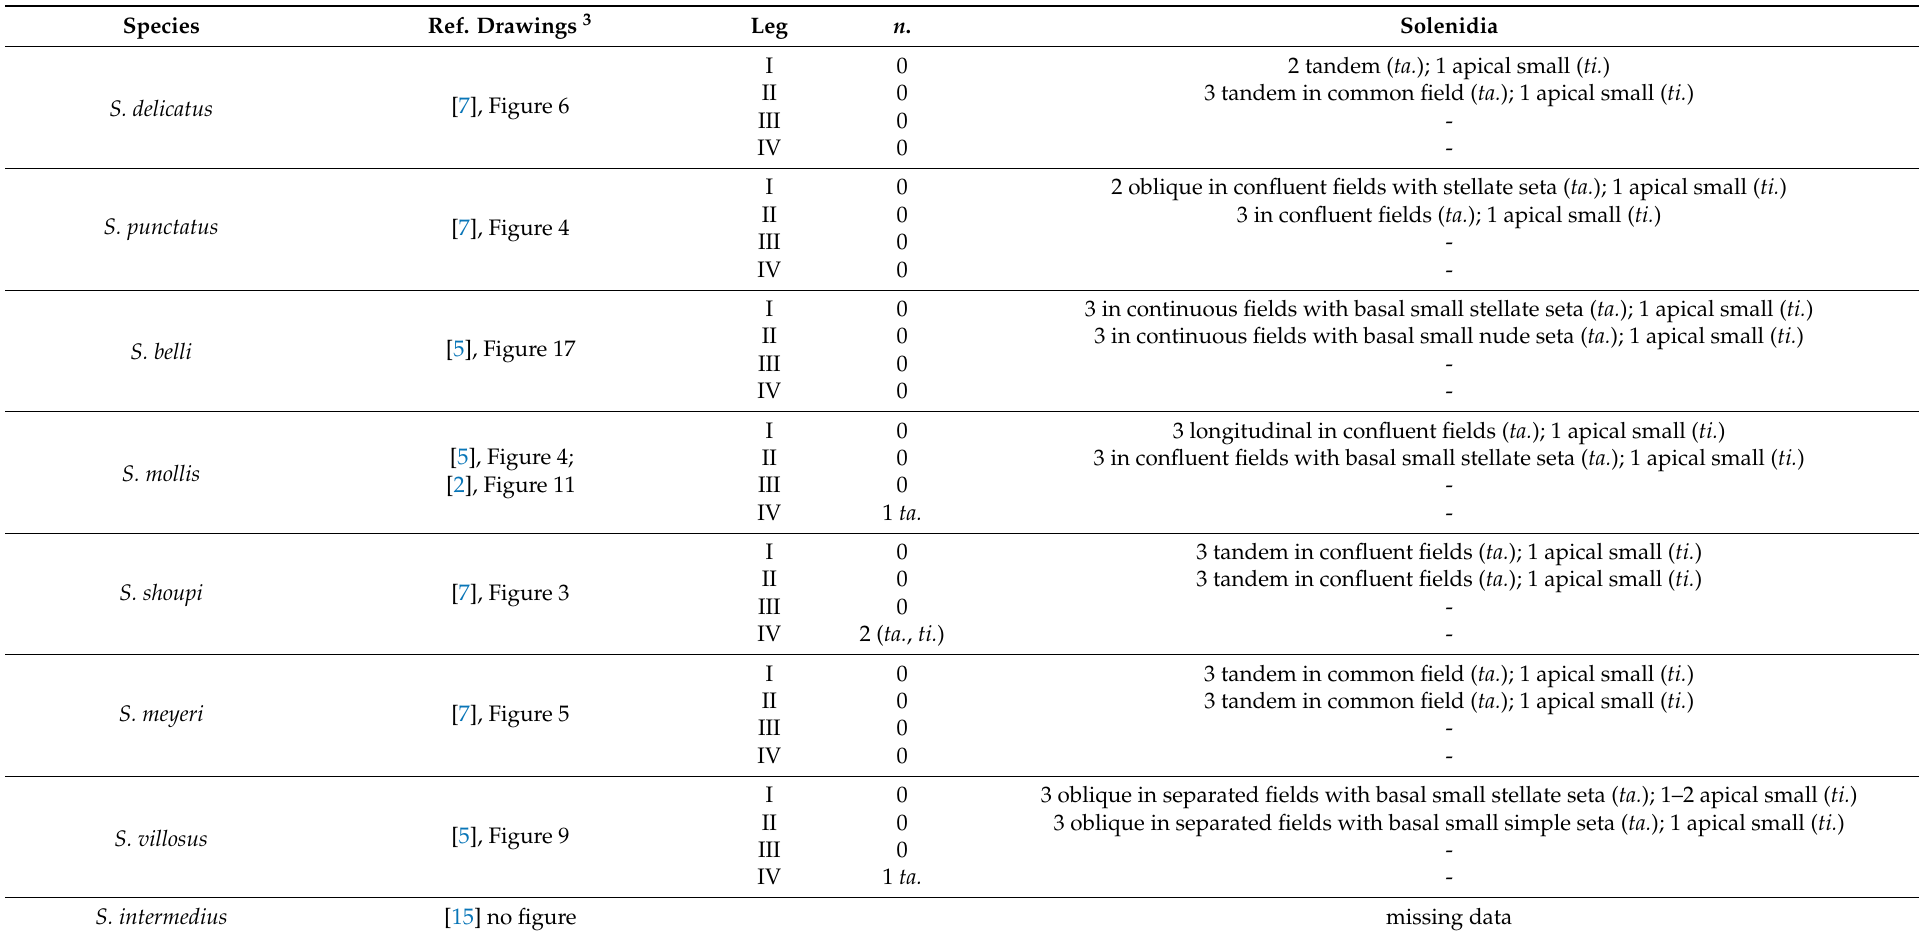
Table A7. Synoptic table of the leg chaetotaxy of the Antarctic and sub-Antarctic Stereotydeus species. n. trichobotria, ti. tibia, ta. tarsus.